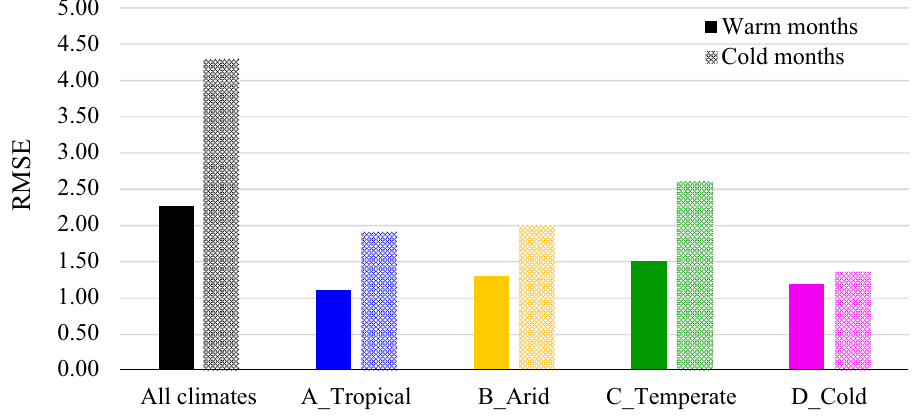
Figure 6. Explanatory potential of all variables on LST, measured by RMSE. A comparison of the explanation rate during warm and cold months before and after classifying